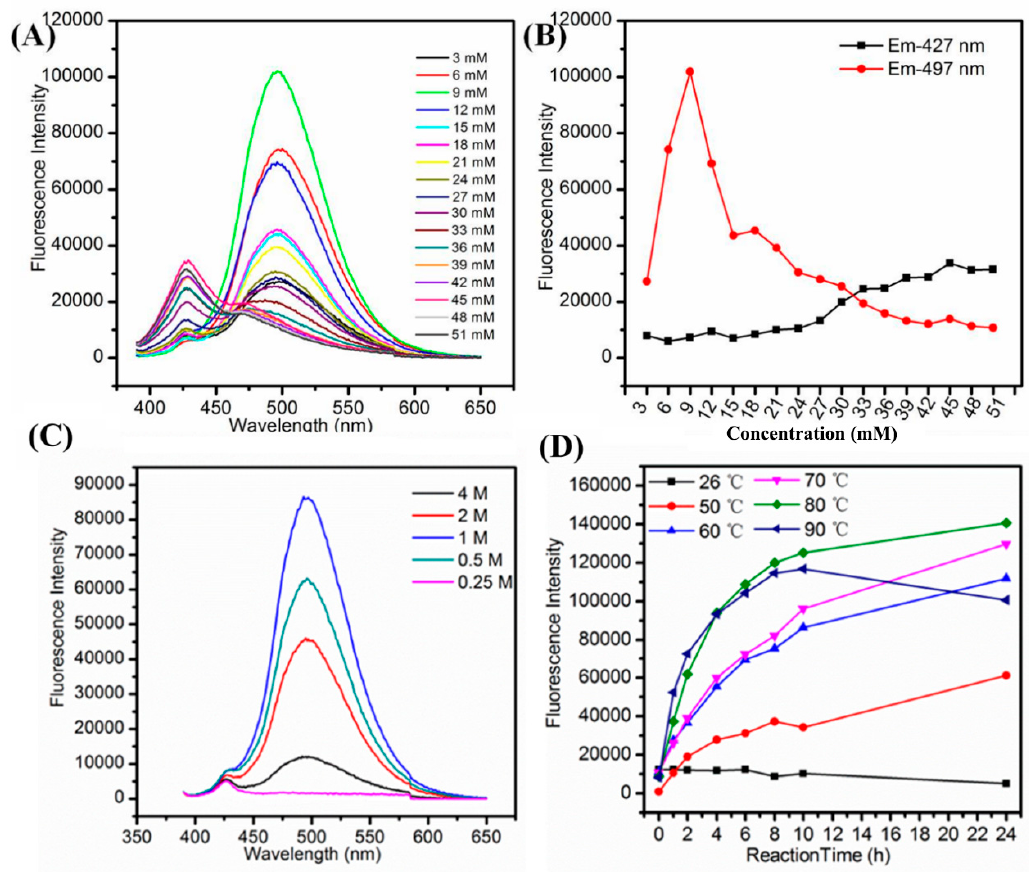
Figure 1. ( A ) Fluorescence emission wavelength; ( B ) trend of fluorescence intensity of the emission peak at 497 nm and 427 nm of Cu NCs@GSH prepared with increasing concentration of GSH from 3 mM to 51 mM; ( C ) fluorescence emission wavelength of Cu NCs@GSH in the presence of different concentration of NaOH; ( D ) trend of fluorescence intensity of Cu NCs@GSH obtained at different temperatures and reaction time.